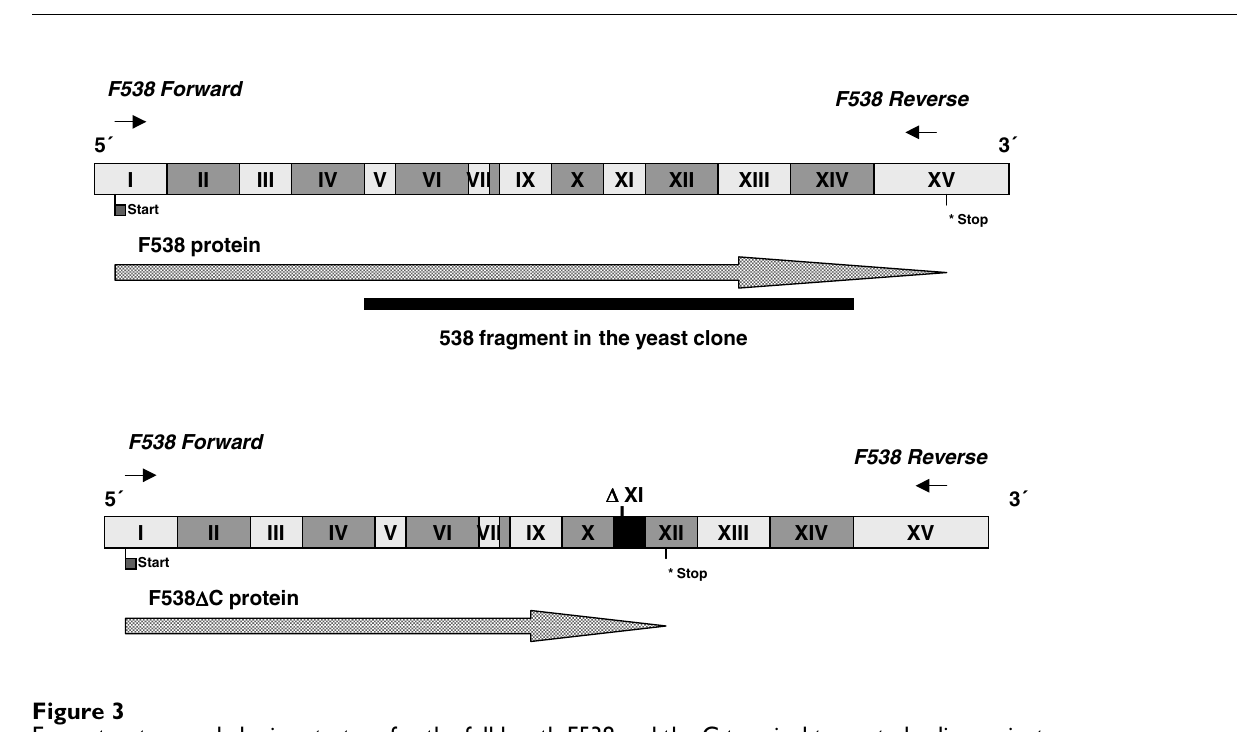
Figure 2 Sequence of F538 that is identical to the hypothetical protein FLJ20517. The sequence of the cDNA fragment isolated from the yeast two hybrid screen is underlined (top) Sequence of the C terminal part of the alternatively spliced variant with the addi- tional ten amino acids preceding the newly created stop-codon (bottom).